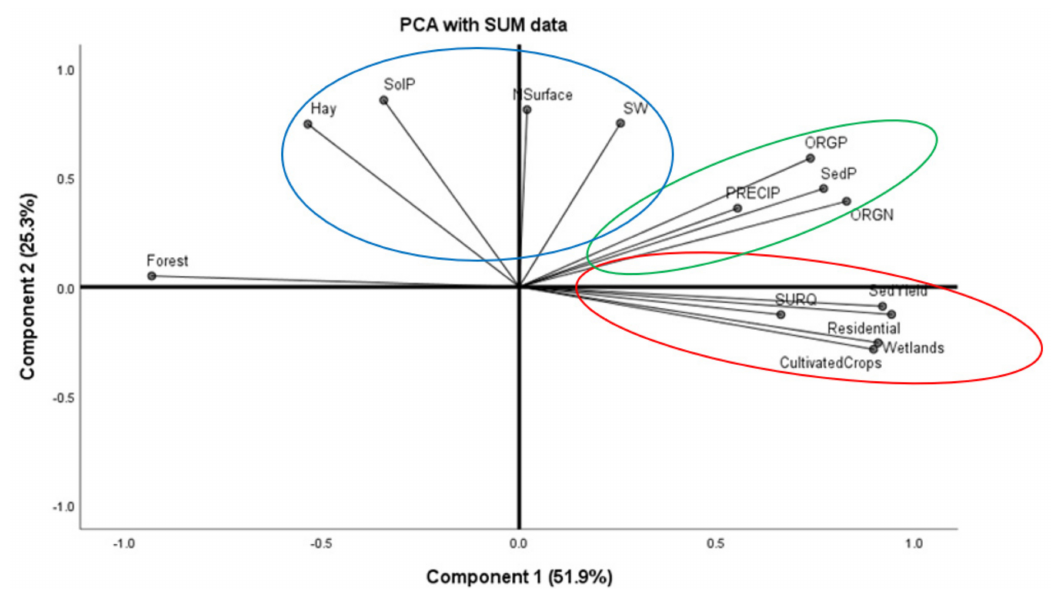
Figure 3. PCA biplot including clusters showing the relationship between the water characteristics parameters (Appendix A Table A2 shows acronym legend) and land